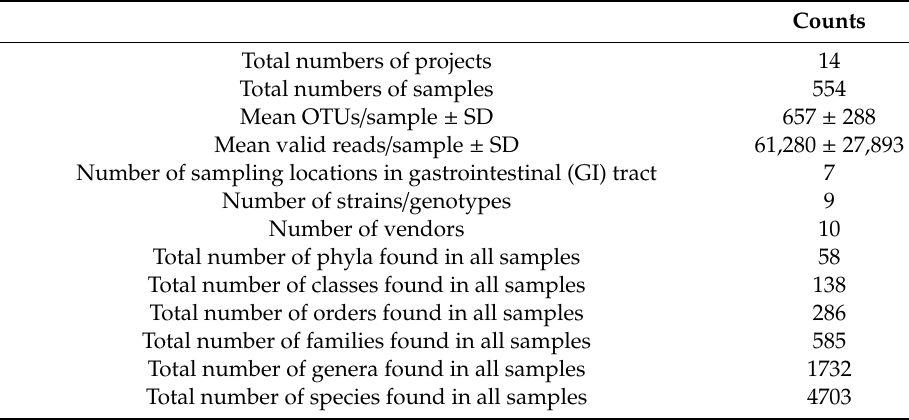
Table 1. Summary statistics of the murine microbiome database (MMDB). OTU, operational taxonomic unit; SD, standard